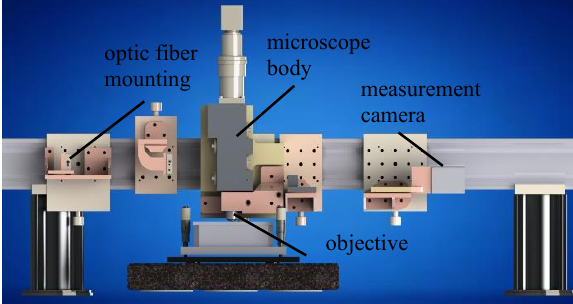
Fig. 1. Illustration of the UV-microscope in its X95